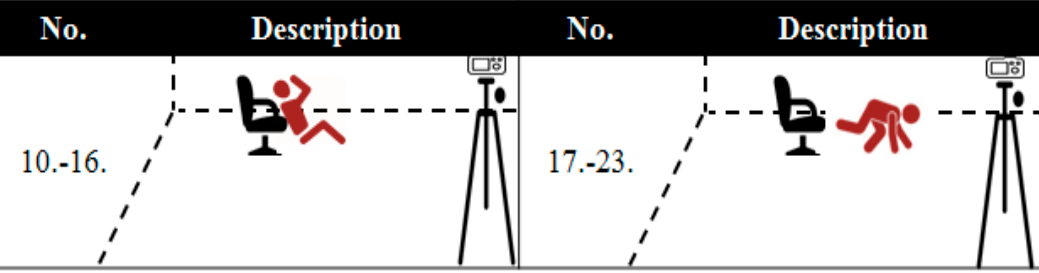
Figure 8. An illustration of the cases with a fall.